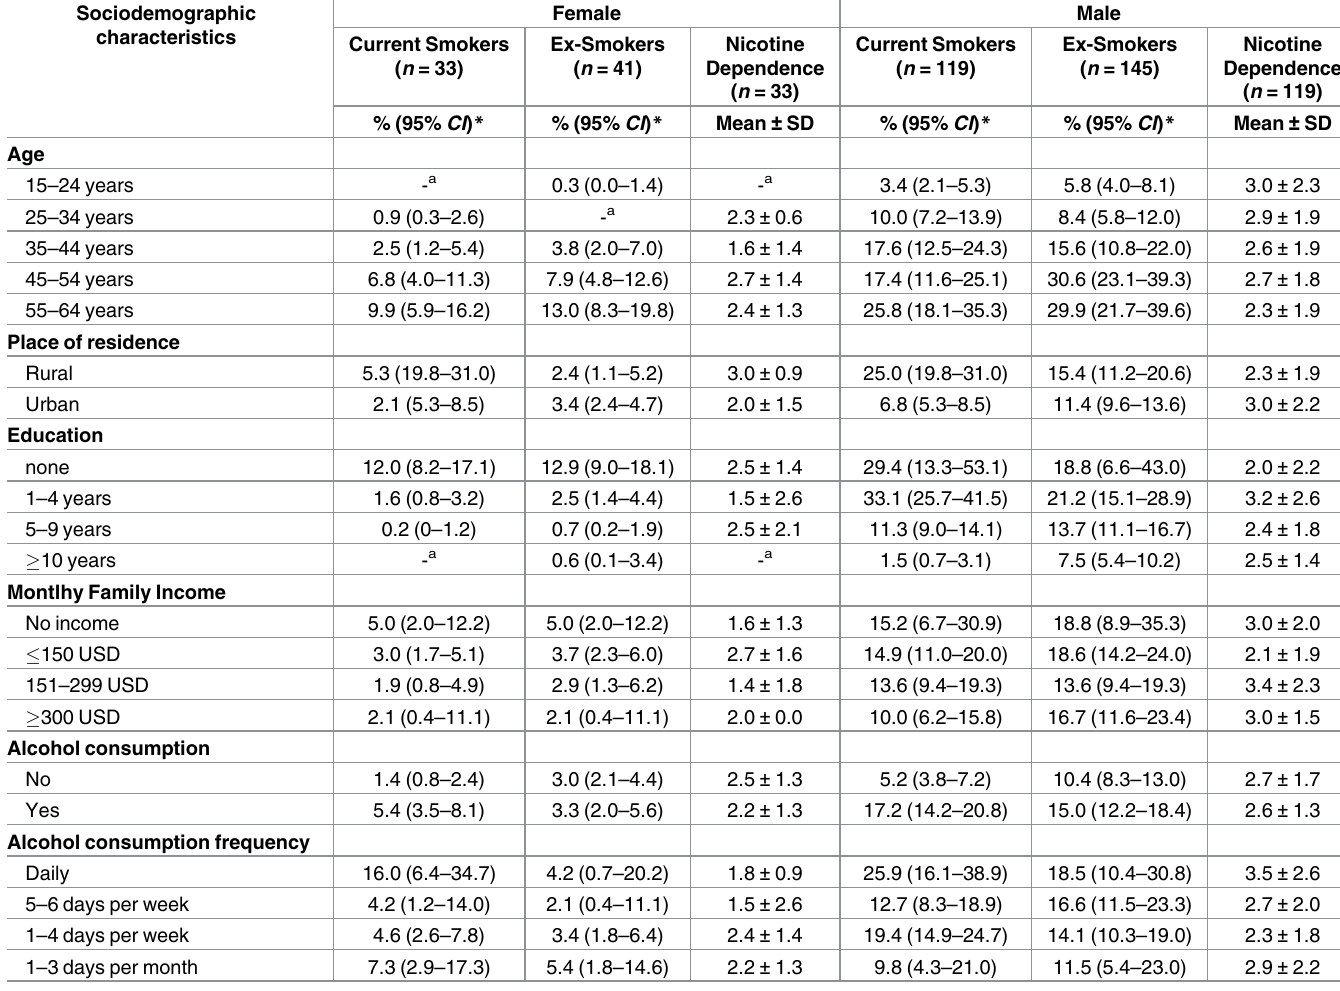
Table 2. Prevalence of smoking and ex-smoking by socio-demographic caracteristics and alcohol consumption frequency, by gender. Sociodemographic